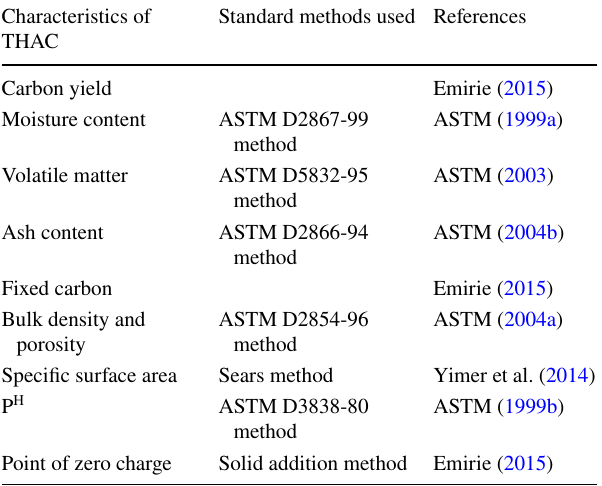
Table 1 Standard methods applied to measure characteristics of THAC